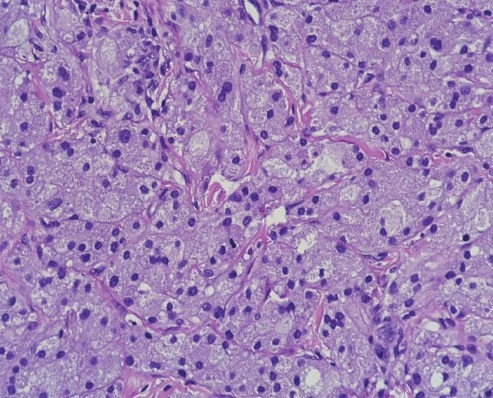
Figure 3: Histologic examination (200X).